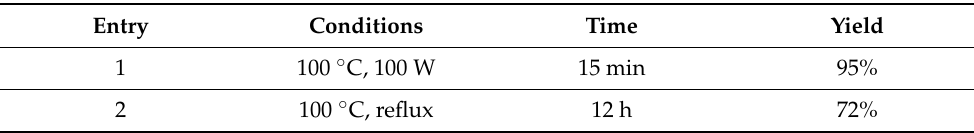
Table 1. Comparison between microwave reaction and conventional heating reaction for the cycliza- tion reaction.